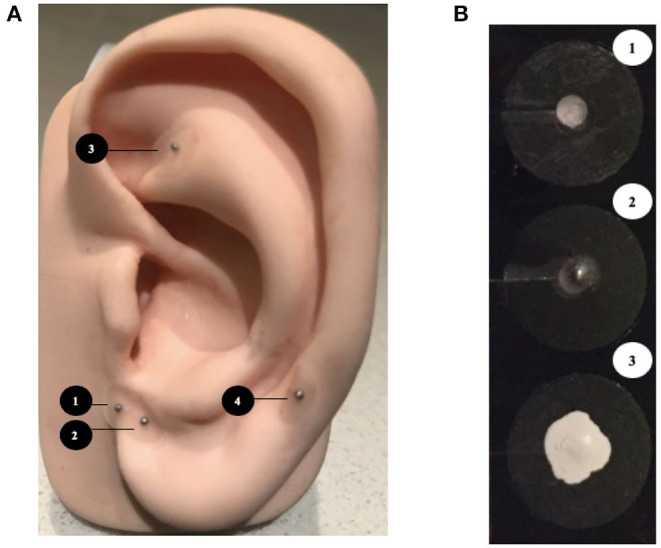
(A) Modified Battlefield acupuncture protocol. The magnets were placed sequentially in the following order: (1) Cingulate Gyrus, (2) Thalamus, (3) Shenmen, (4) Cranial Nerve-5 (Ophthalmic branch).9,10 (B) (1) The placebo sticker (2) magnet sticker (3) concealment by white correction fluid.